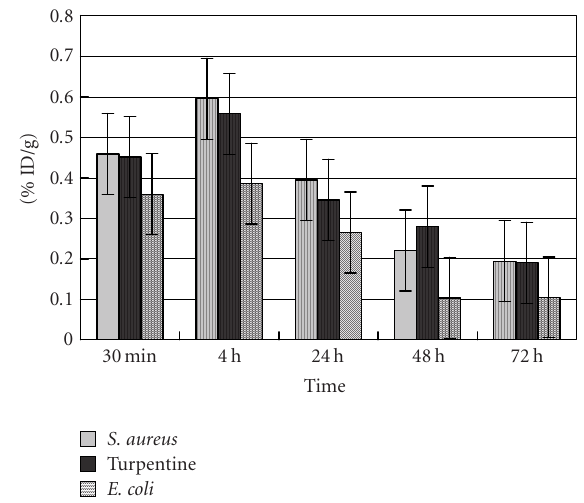
Figure 1: Clearance of 125 I-anti-MIF McAb from the blood in S. aureus group, E. coli group, and turpentine oil group (% ID/g, x ± s).